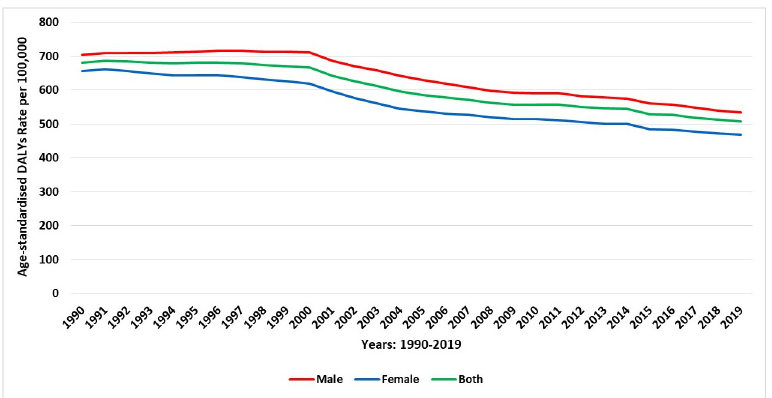
Fig 5. Trends in the age-standardised DALYs rate of COPD during 1990–2019 in Saudi Arabia, stratified by gender.